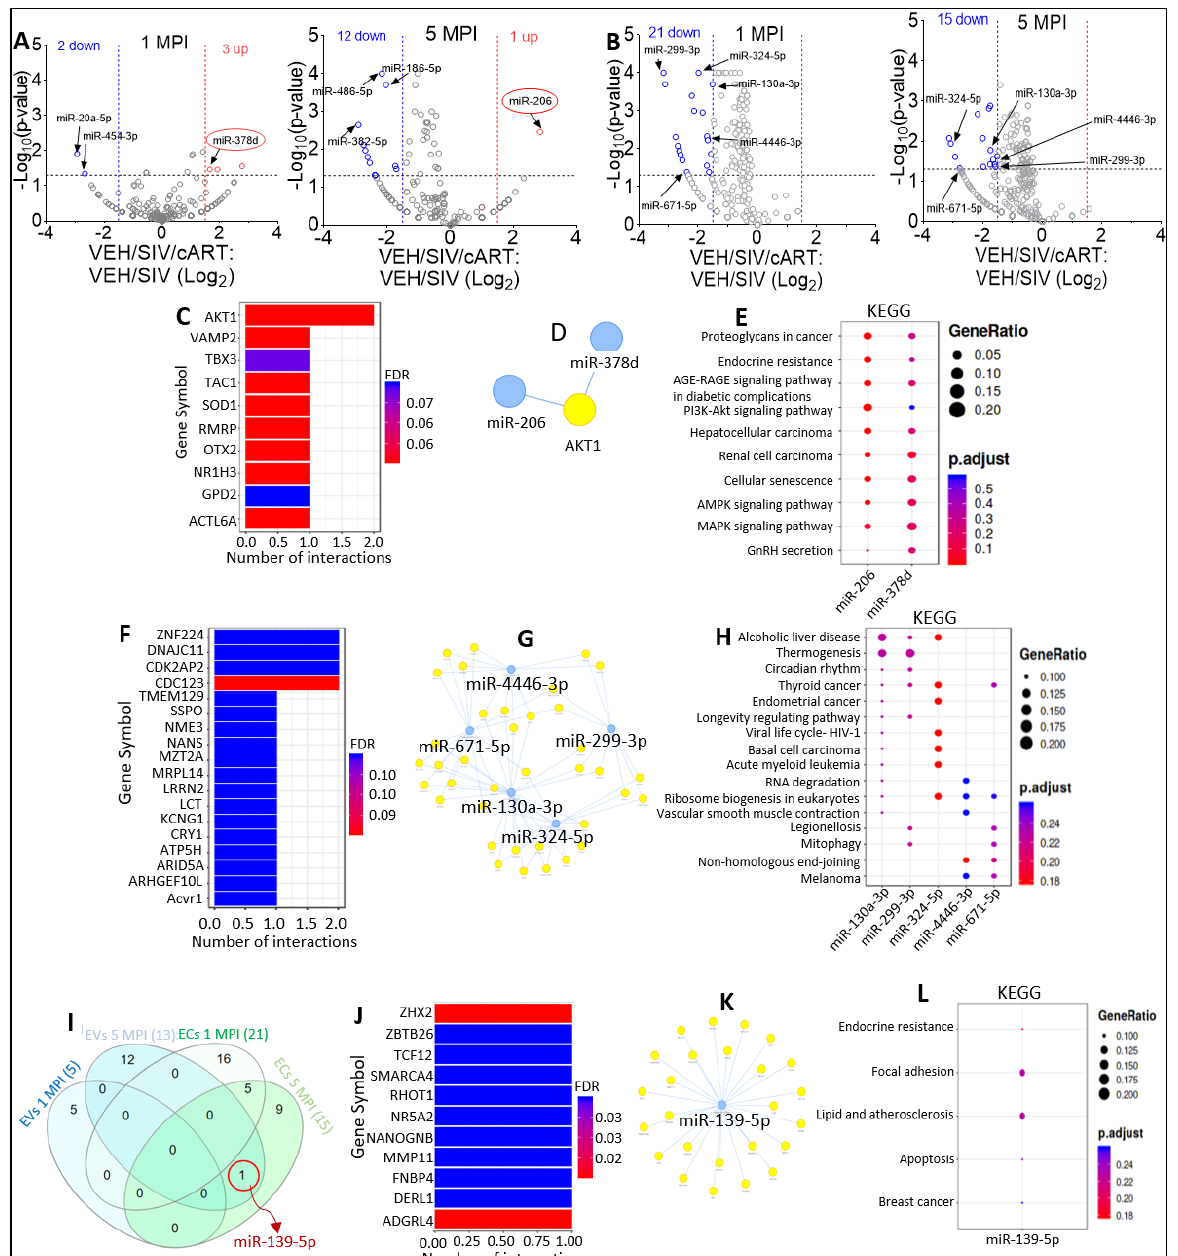
Figure 3. Varying miRNA abundance in EVs and ECs in response to SIV infection and cART. ( A ) Volcano plot showing down-(blue) regulated and up-(red) regulated miRNAs in VEH/SIV/ART EVs relative to VEH/SIV EVs at 1 MPI (left) and 5 MPI (right) as shown by black arrows. Red circle indicates miRNAs (miR-378d, miR-206) suppressed by SIV infection in Figs. 5C, 5E of Manuscript 1. ( B ) Volcano plot showing down-(blue) regulated miRNAs in SIV/ART ECs relative to SIV ECs at 1 MPI (left) and 5 MPI (right). Black arrows indicate miRNAs shown to be significantly downregulated at 1 MPI and 5 MPI. ( C ) miRNA-target enrichment analysis showing top target genes by # of interactions for miR-206 and miR-378d. ( D ) Visualization of miRNA-target interaction network for miR-206 and miR-378d. The blue circles represent the miRNAs, while the target genes are represented by the yellow circles. Pathways are represented by blue lines. ( E ) Dot plot of functional enrichment analysis for target genes of miR-206 and miR-378d. Color of dots represent adjusted p-values (FDR) and size of dots represents gene ratio (number of miRNA targets found enriched in each category/number